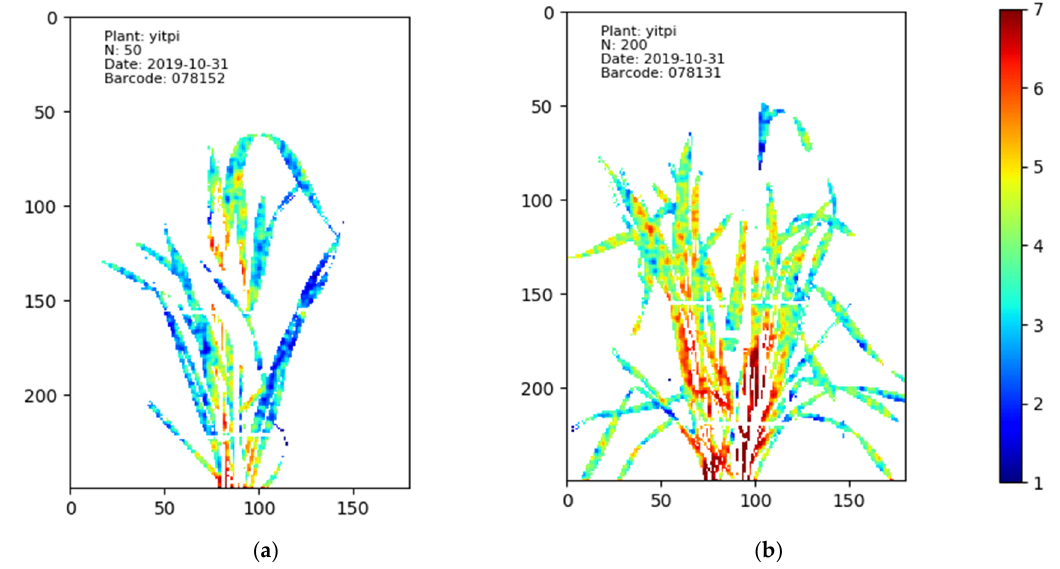
Figure A5. The N distribution maps of Yitpi on 31 October 2019 with the different N treatments. The best performing model trained using the SWIR camera data was used to create N distribution maps. The different colours represent different levels of N%. In image ( a ), the plant treated with 50 mg/kg N has more blue pixels than the plant treated with 200 mg/kg N shown in image ( b ), saying that the leaves shown in ( a ) have lower N content than that shown in ( b ).